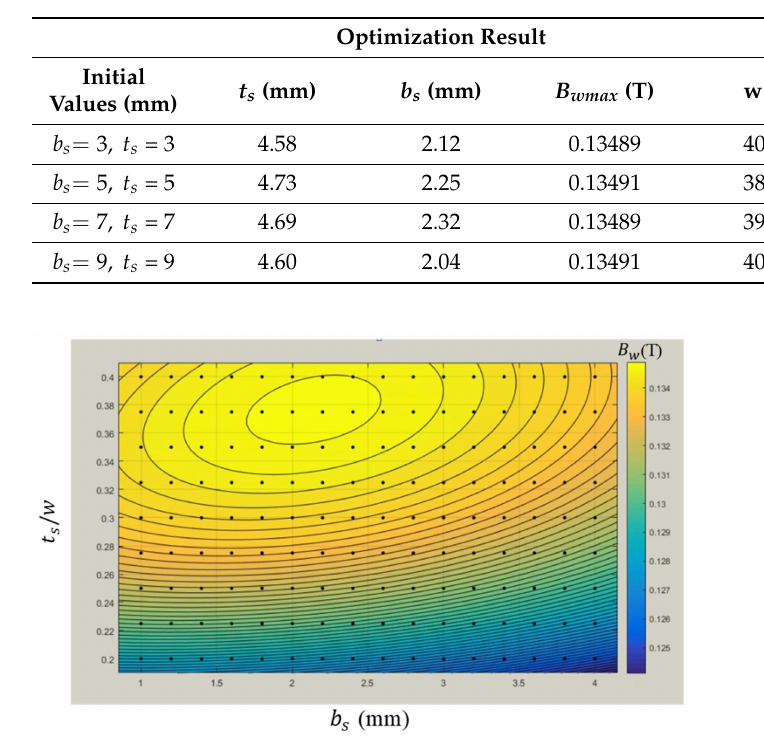
Table 1. Optimization Results of Multiple Initial Values.